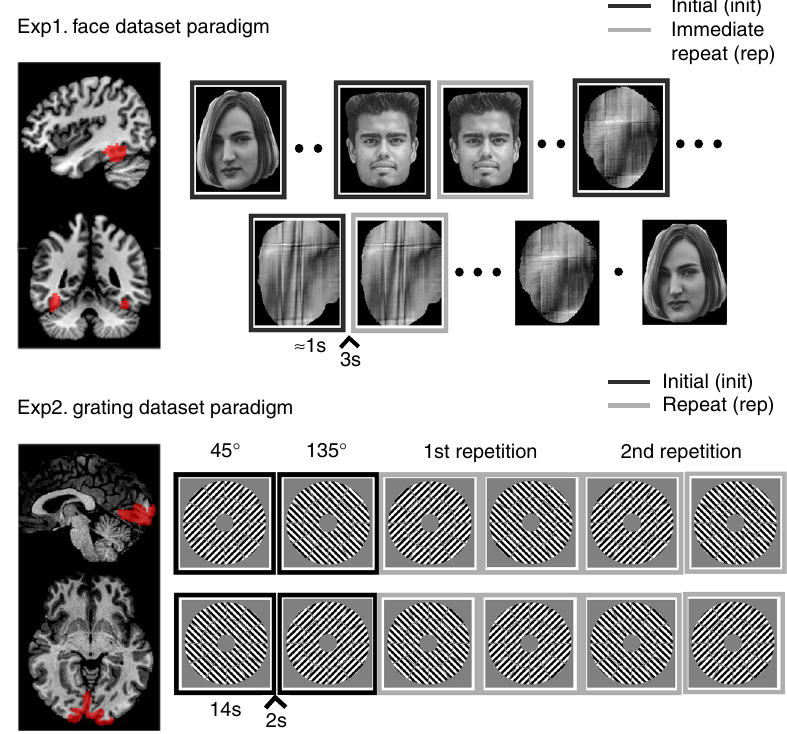
Fig. 2 Visualisation of the two experimental paradigms and the corresponding brain region used in the analyses. Note that in our analyses we randomly dropped half of the initial trials in the Face dataset to balance the number of the initial and immediate repeats and that we used the 2nd repetition as the repeat condition for Experiment 2. The two face images shown are open license images presented for illustrative purposes only. The actual images used during Experiment 1 are described in Wakeman and Henson